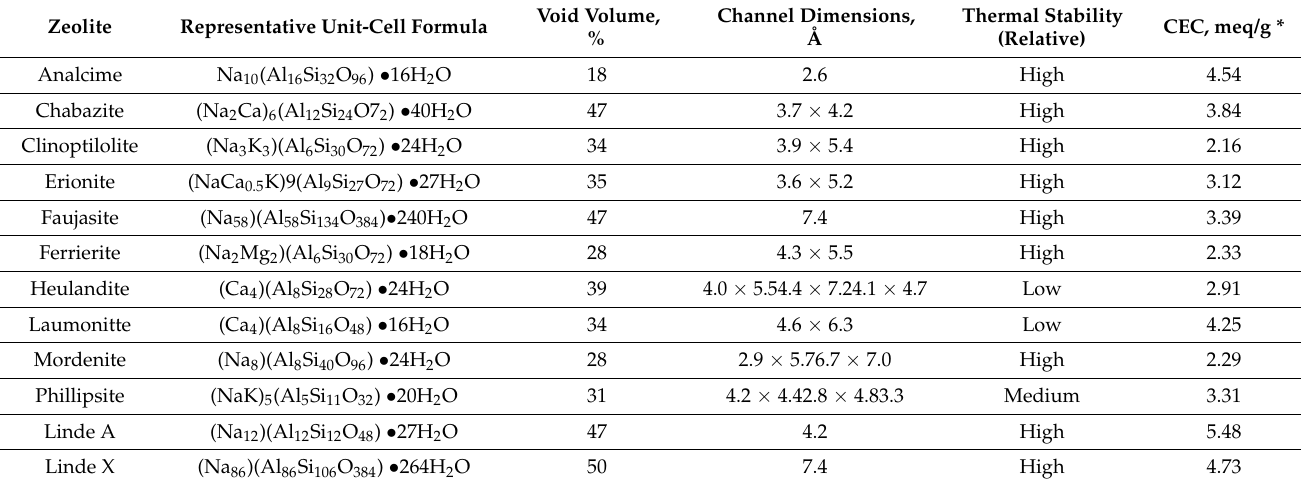
Table 1. Representative formulae and selected physical properties of important zeolites. Reproduced from [38], with permission from “Copyright (1999) National Academy of Sciences, U.S.A.”. * Calculated from unit-cell formula. Zeolite Representative Unit-Cell